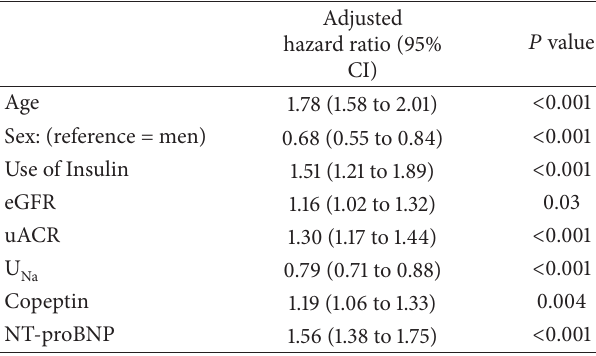
Table 4: Multivariate Cox proportional hazards model for the risk of all-cause death (best fitted